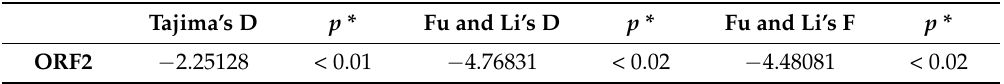
Table 2. Neutrality tests of ORF2 sequences.